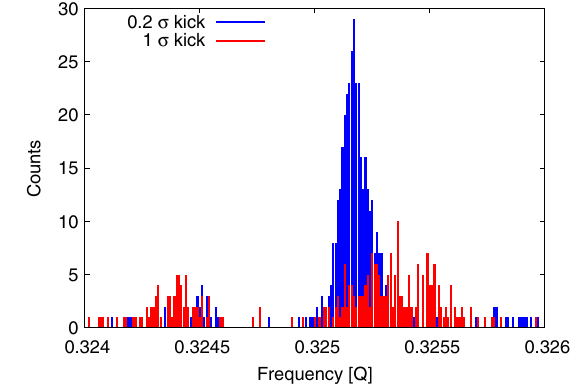
FIG. 11. Comparison of tune distribution for low amplitude and 1 (cid:6) oscillation amplitude which corresponds to the data set shown in Fig. 10. An SVD cut of 20 was performed for both data sets.